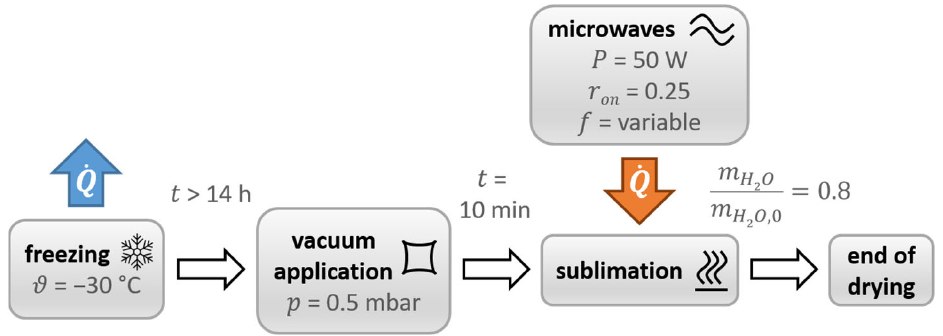
Figure 3. Schematic overview of the process steps and corresponding parameters for MFD.